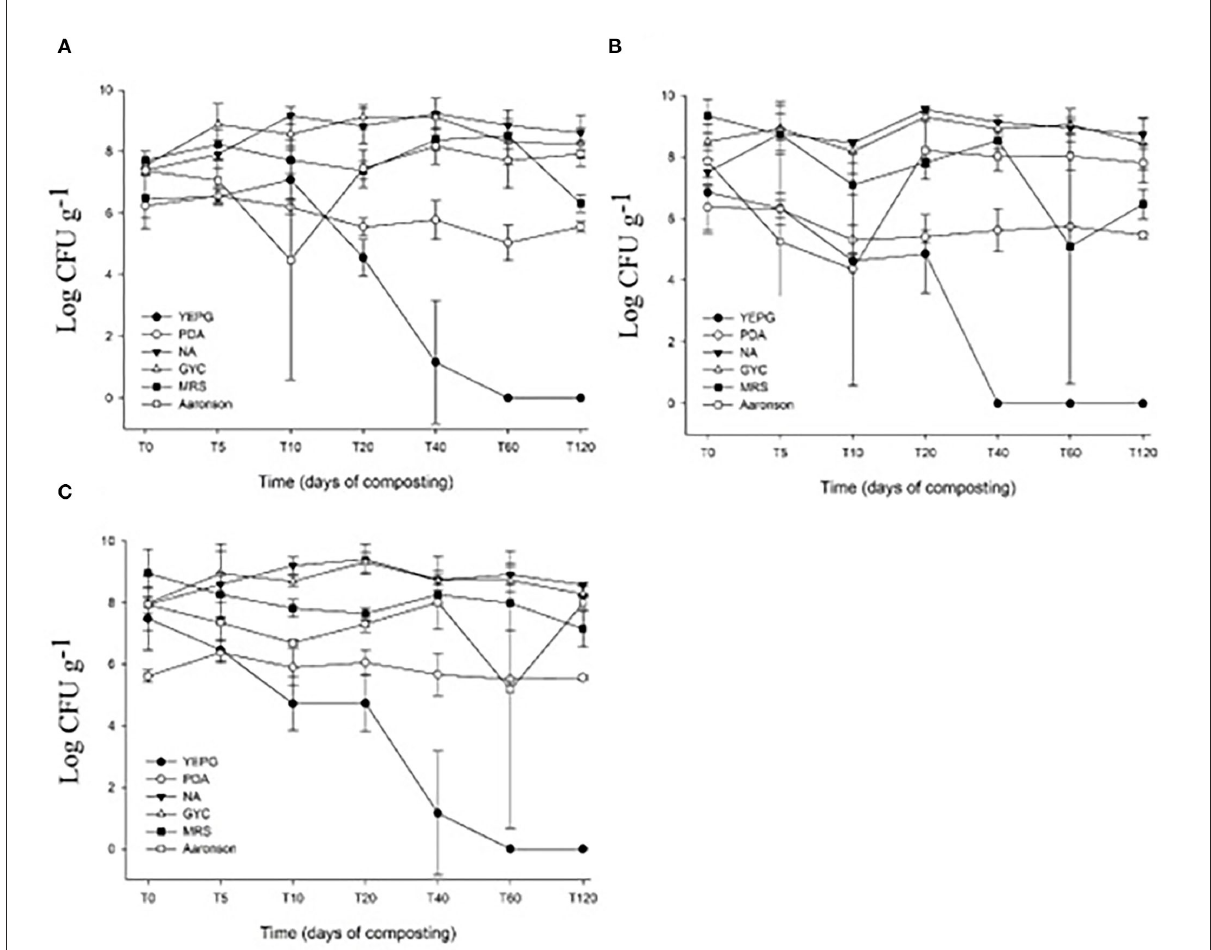
FIGURE4 Variation in the total count of microorganisms (log UFC g − 1 of compost) during composting. (A) Treatments with efficient microorganisms EM. (B) Control treatment. (C) Treatment with commercial inoculum. YEPG, yeast; PDA, filamentous fungi; NA, total mesophilic bacteria; MRS, lactic bacteria; GYC, bacteria of acetic acid and Aaronson–Actinobacteria. *CFU, colony form